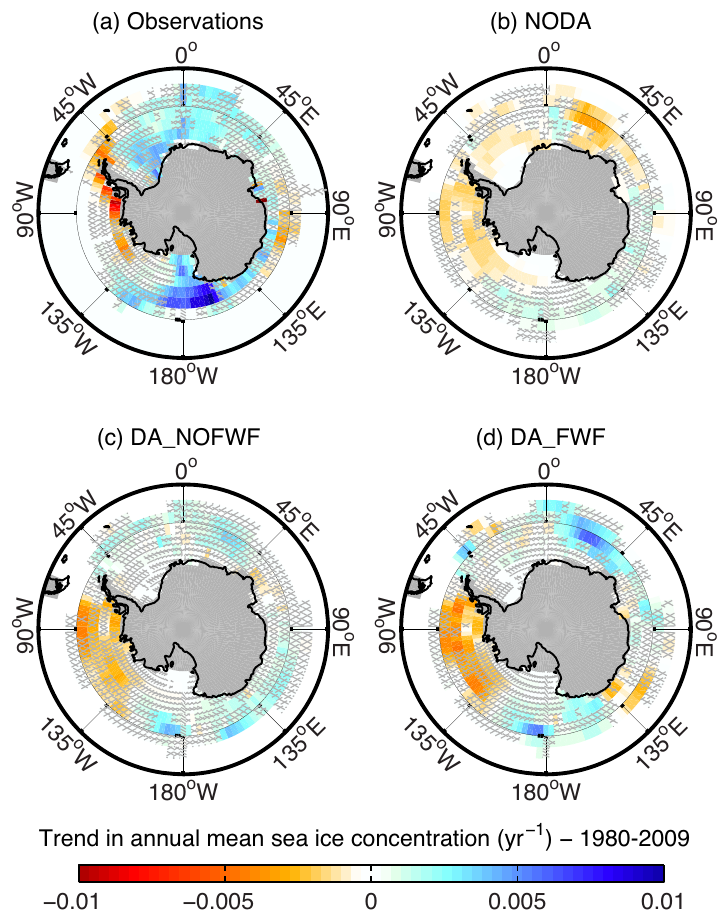
Figure 3. Trend in yearly mean sea ice concentration between 1980 and 2009, shown for (a) the observations (Comiso, 1999), (b) the model simulation without data assimilation (NODA), (c) the model simulation that assimilates anomalies of surface air temperature (DA_NOFWF) and (d) the model simulation that assimilates anomalies of surface air temperature and that is forced by an additional autoregressive freshwater flux following Eq. (1) (DA_FWF). Hatched areas highlight the grid cells where the trend is not significant at the 99% level. The shaded grey areas correspond to the land mask of the ocean model. Table 2. Correlation between the ocean heat content in the first 100m below the surface and the ocean heat content between − 500 and − 100m (second column) and correlation between the ocean heat content and the ocean salt content in the first 100m below the surface (third column), for the different simulations summarised in Table 1. The correlation is computed over the period 1980 and 2009, from the ensemble mean of the variables. For the simulation NODA, the correlation computed for each member of the simulation and averaged over the ensemble is given in